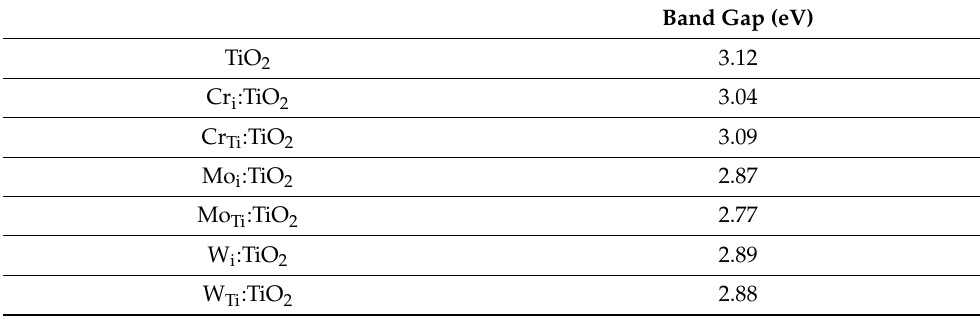
Table 2. The calculated band gap values for every interstitial and substitutional doping